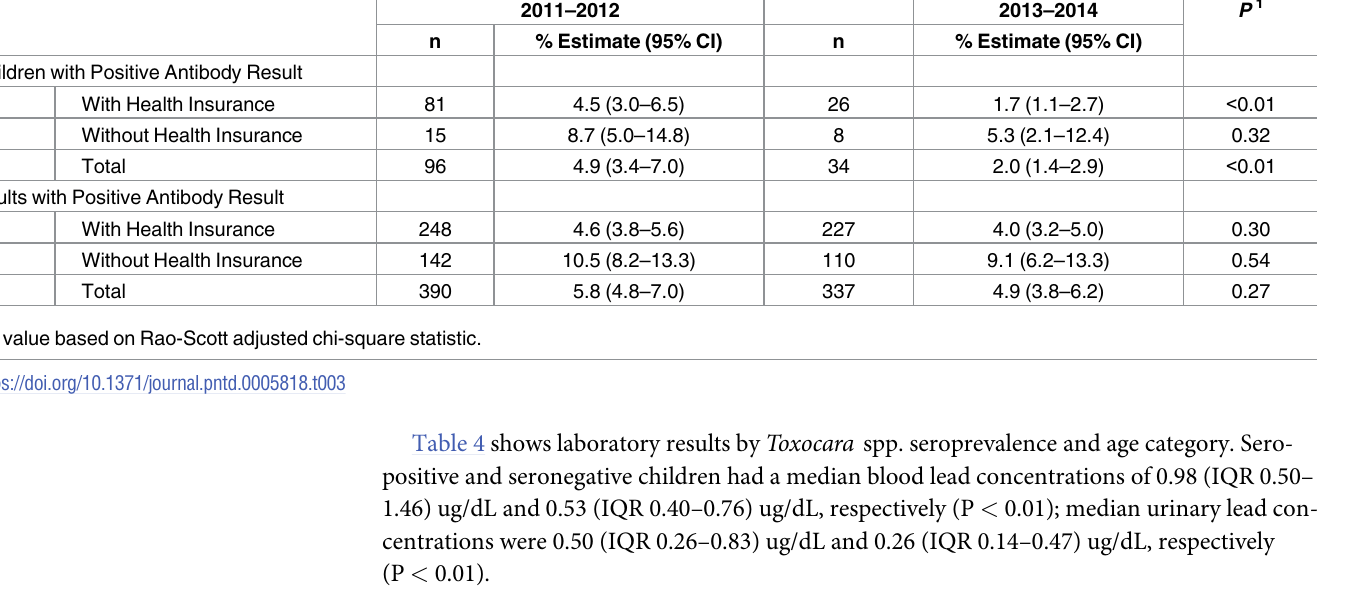
Table 3. Toxocara spp. antibody prevalenceby time.